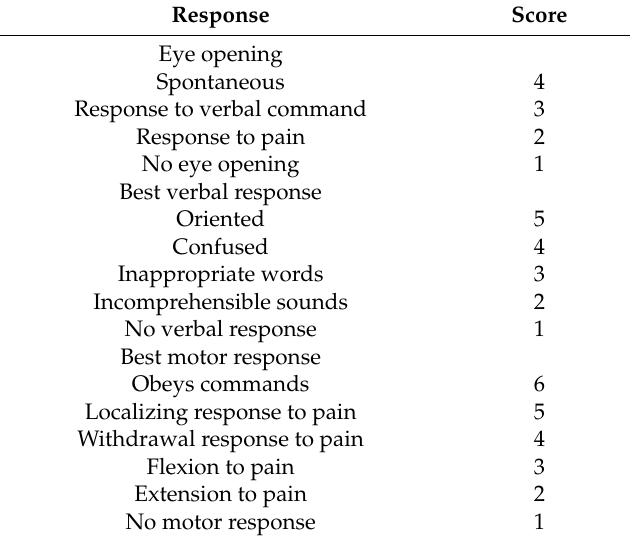
Table 1. Glasgow Coma Scale (GCS). A GCS score of 13 to 15 is considered mild injury, 9 to 12 is considered moderate injury, and 8 or less as severe traumatic brain